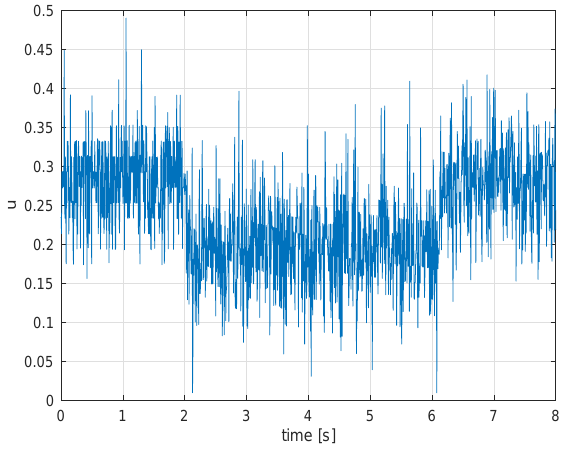
Figure 21. Experimental Result: Average value of